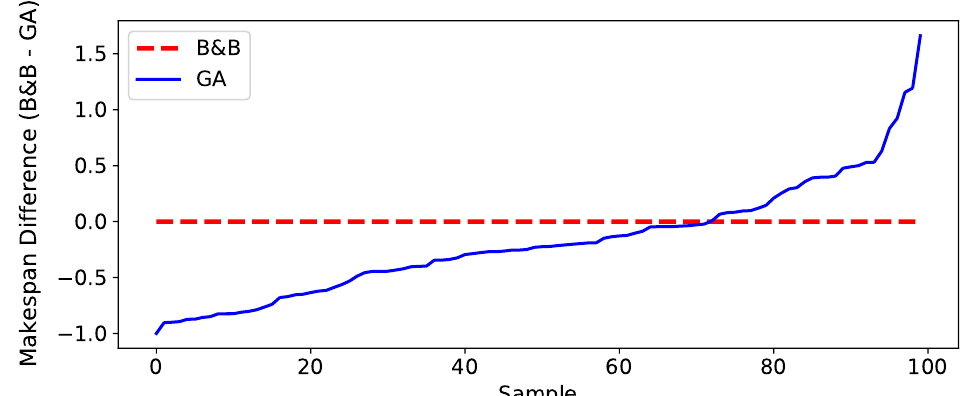
Figure A5. The difference of makespan ( makespan MH − makespan B & B ) in Figure A4. Note that there are some samples whose performance is better than the optimal solution which represents the gap between the mixed integer programming formulation and the RL